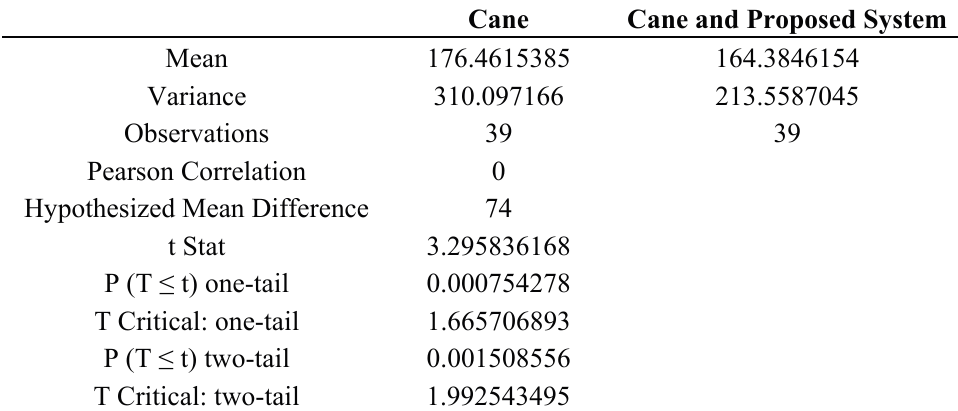
Figure 30. The distribution of the experimental data. Table 7. t -Test: Paired Two Sample for Means. Cane Cane and Proposed